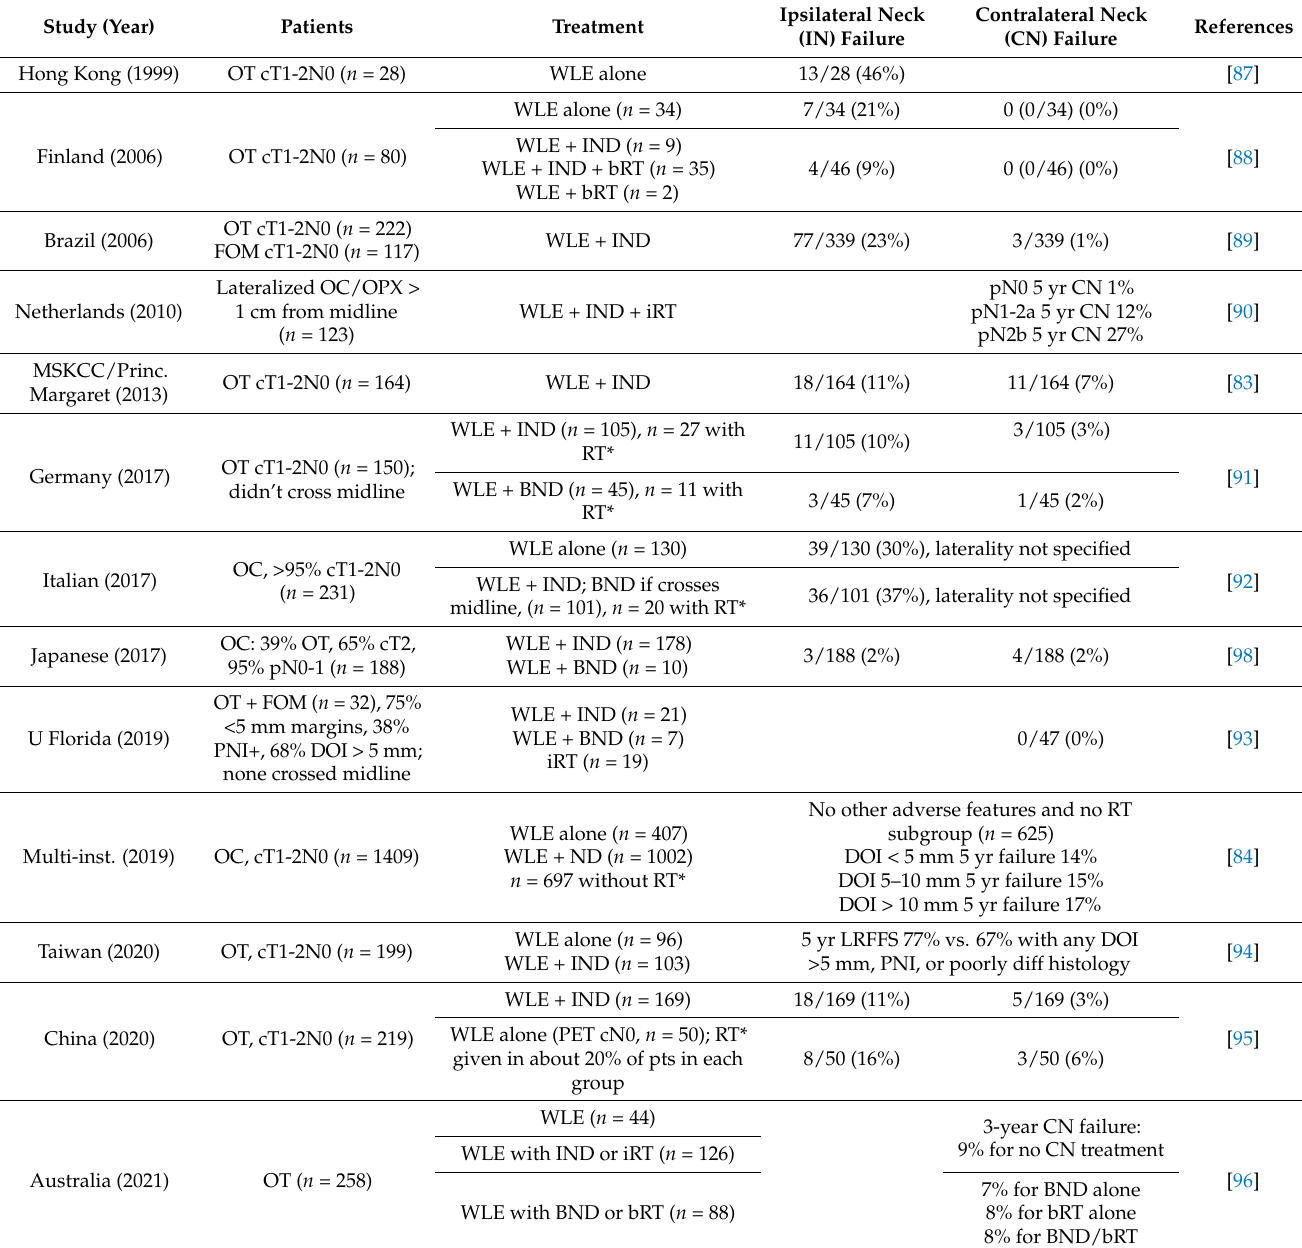
Table 2. Retrospective studies of patterns of failure in early-stage oral cavity